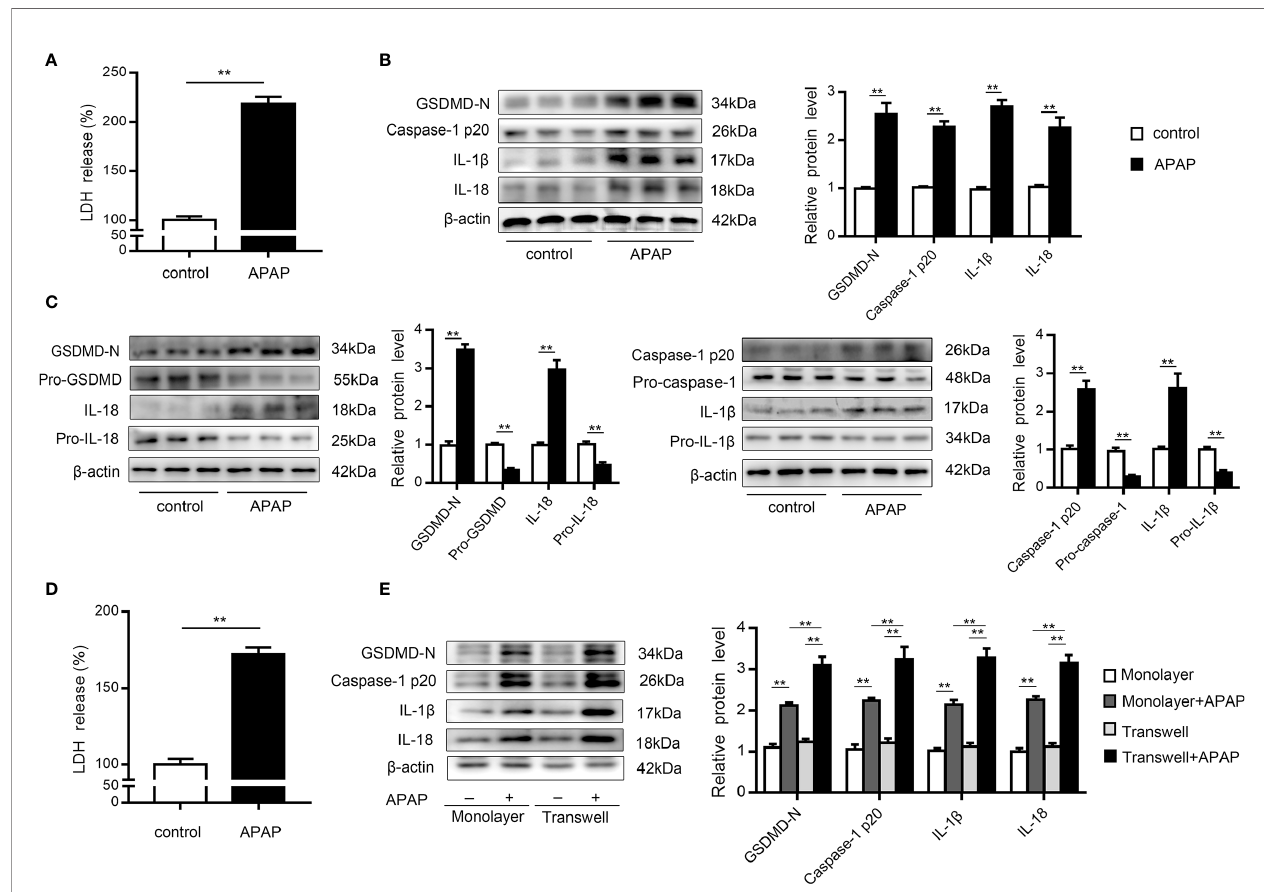
FIGURE 2 | Primary KCs and hepatocytes undergo pyroptosis upon APAP treatment. Primary cells were plated on rat tail collagen-coated plates, and APAP (10 mM/well) was administered after stable adherence. (A) Kupffer cellular supernatant levels of LDH were assessed, n=6. (B) GSDMD-N, caspase-1 p20, IL-1 b , and IL- 18 protein levels in primary KCs were determined, n=3. (C) Pro-GSDMD/GSDMD-N, pro-caspase-1/caspase-1 p20, pro-IL-1 b /IL-1 b , and pro-IL-18/IL-18 protein levels in primary hepatocytes were determined, n=3. (D) Hepatocellular supernatant levels of LDH were assessed, n=6. (E) Primary hepatocytes were obtained from untreated C57BL/6 mice and reseeded in a monolayer or the lower chamber of a transwell system. For coculture, primary KCs from untreated C57BL/6 mice were reseeded in the upper chamber of the transwell system. The levels of the indicated proteins (GSDMD-N, caspase-1 p20, IL-1 b , IL-18) in the primary hepatocytes from the monolayer or transwell cultures were detected by western blotting, n=3.